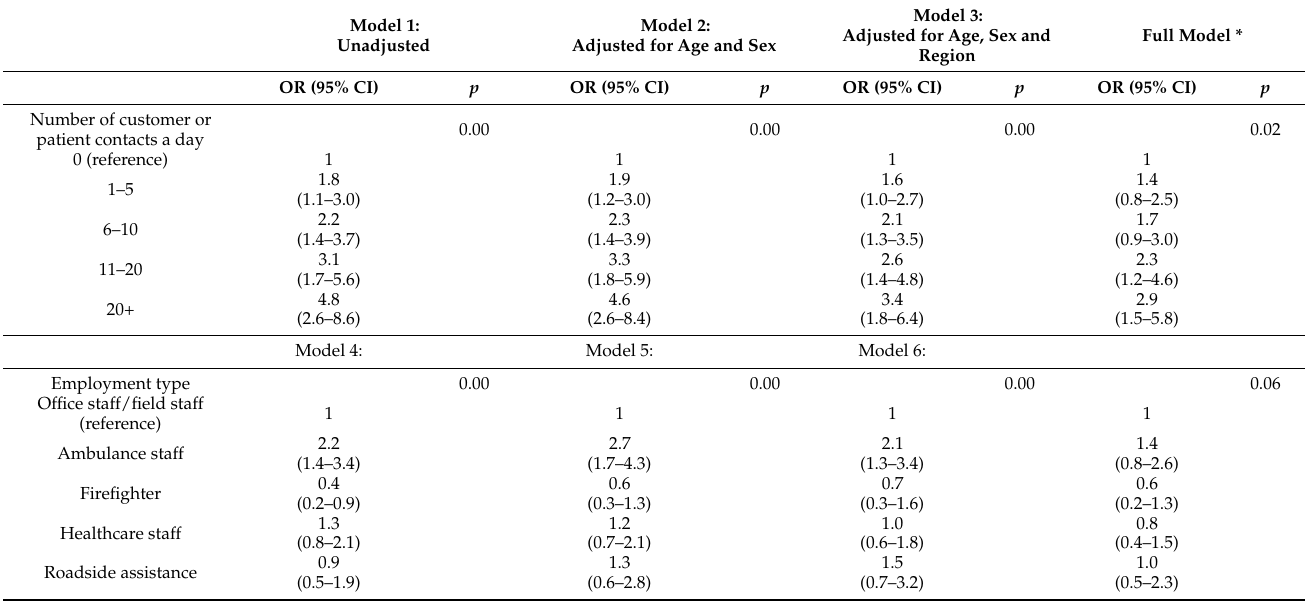
Table 3. Logistic regression of risk of positive immune COVID-19 test.